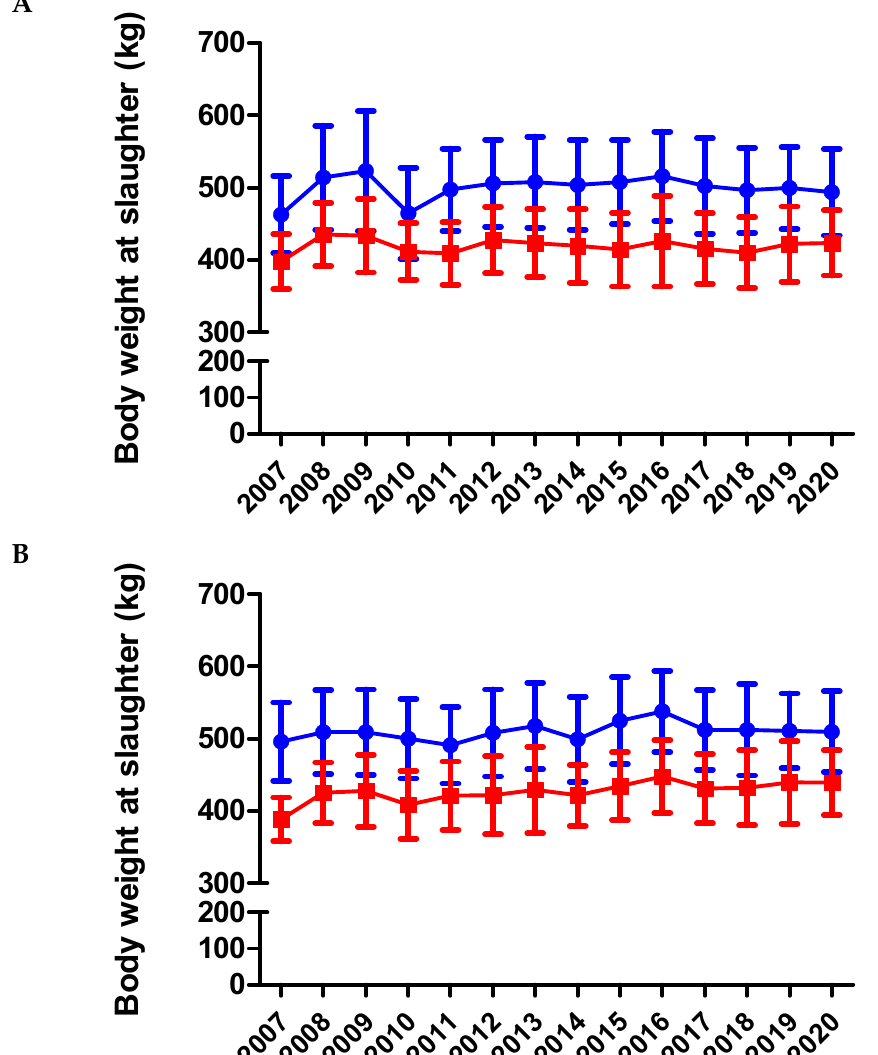
Figure 9. Body weight at slaughter from BA ( A ) and BAxL ( B ) split by males (blue filled circles) and females (red filled squares) from 2007 to 2020 in Andorra. Males had higher BW at slaughter than females in both BA and BAxL groups ( p < 0.001) without observing a significant trend across the study period ( p > 0.05).